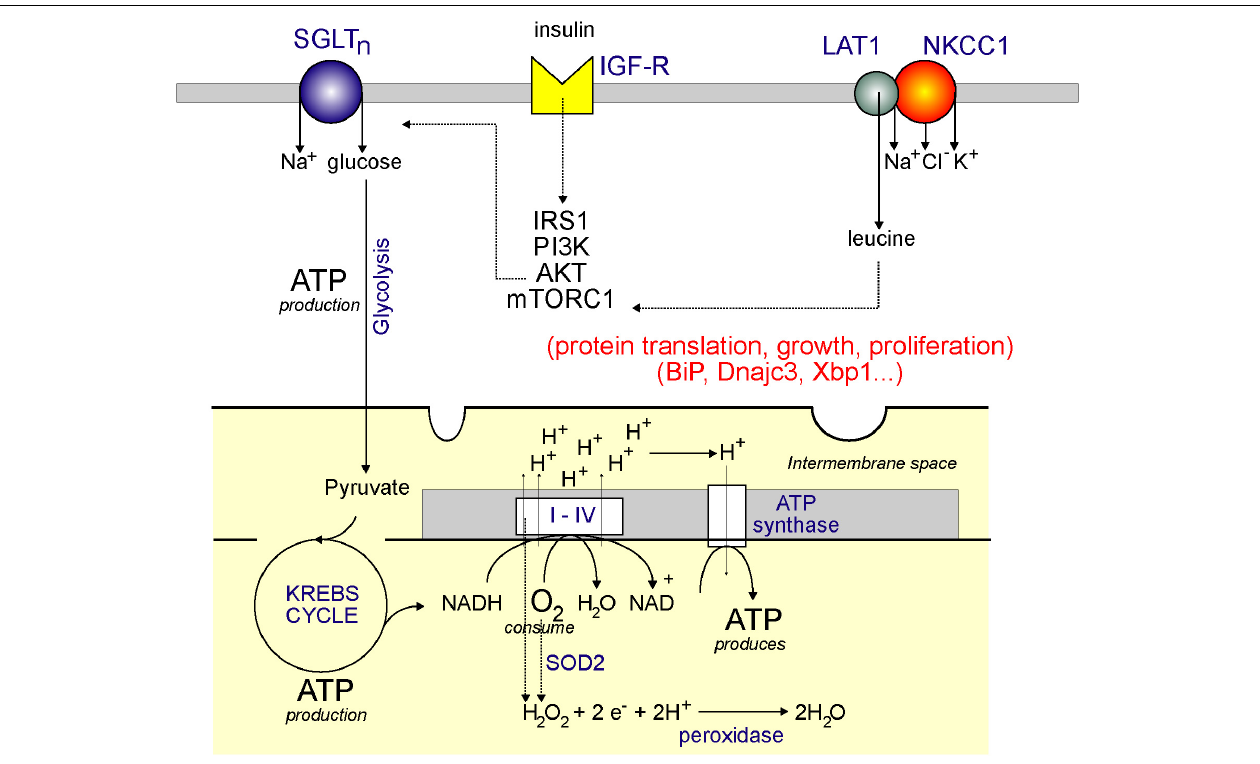
FIGURE 4 | Model showing plasma membrane NKCC1 and mitochondrial respiration: a link through leucine? Aerobic respiration utilizes the KREBS cycle and the electron transport chain. Through the consumption of oxygen (O 2 ) and NADH (produced by the KREBS/TCA cycle), complexes I–IV produces a proton (H + ) gradient in the inner membrane of the mitochondria, which is then used by ATP synthase to produce ATP. The KREBS or TCA cycle is powered by pyruvate which comes from glucose through the process of glycolysis. The glucose comes from uptake at the plasma membrane through a Na + -driven glucose transporter. Glucose transport is facilitated by activation of the IGF-R receptor by insulin and stimulation of the IRS1/PI3K/AKT pathway. AKT also stimulates mTORC1, which stimulates protein translation, thereby facilitating cell growth and proliferation. mTORC1 is also stimulated by leucine which enters cells through the LAT1 transporter –